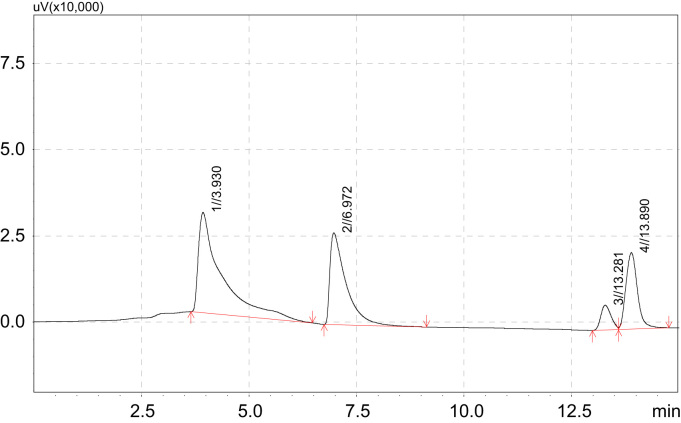
Sample standard.